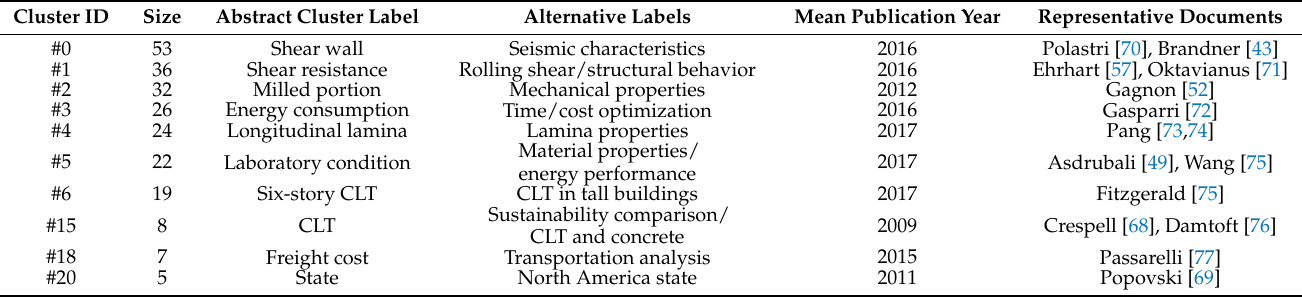
Table 6. Co-citation clusters of cross-laminated timber in construction from 2006 to